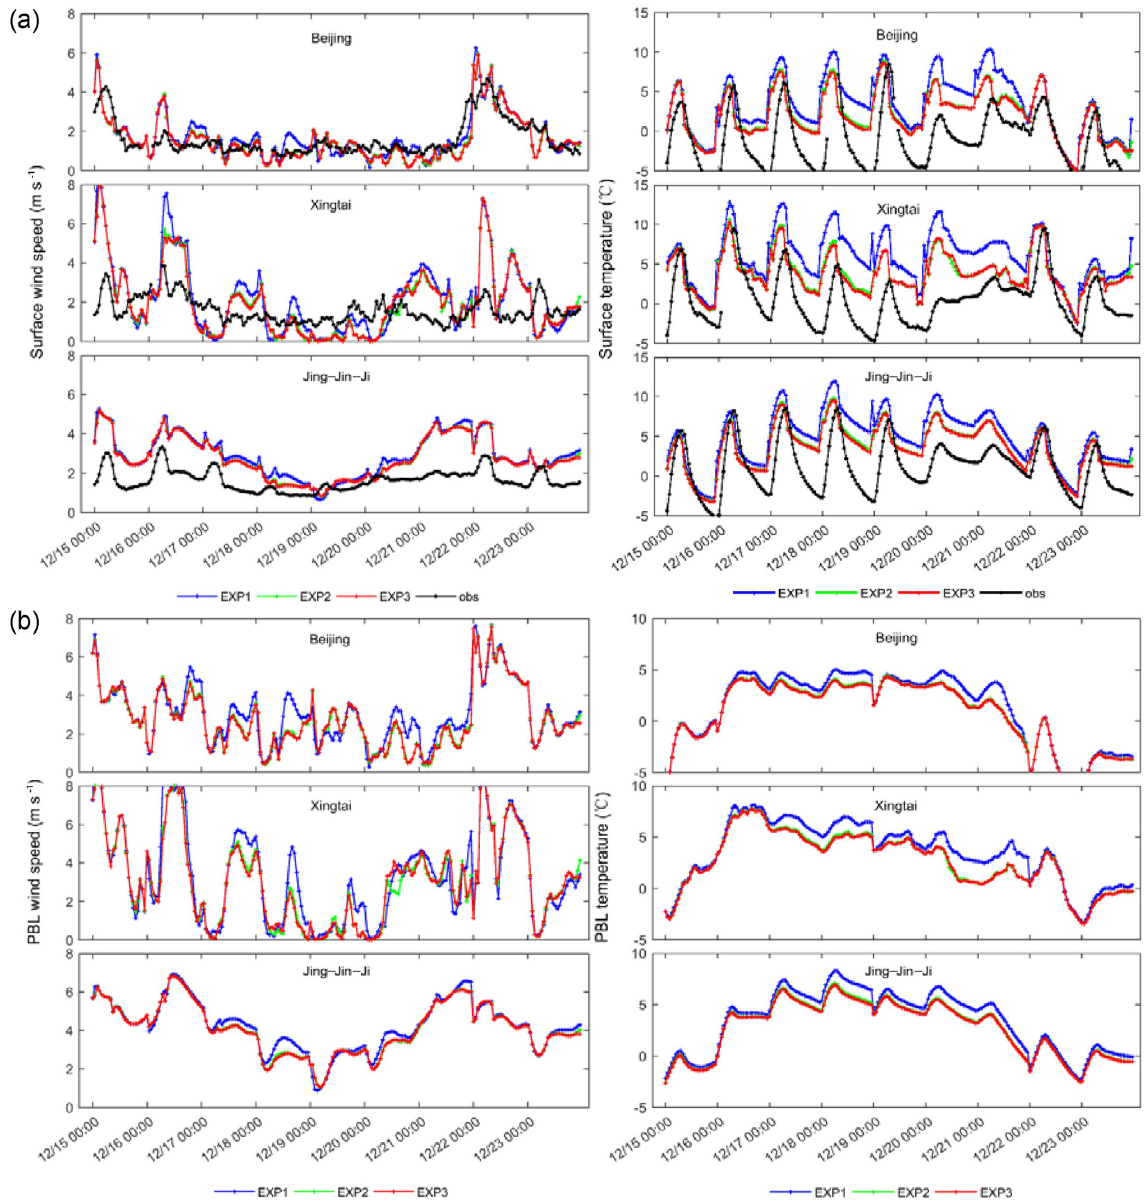
Figure 3. Observed and modelled wind speed and temperature at the surface (a) , and the PBL-mean wind speed and temperature (b) , from the results of EXP1, EXP2, and EXP3 for Beijing, Xingtai, and the average for the Jing–Jin–Ji region as a whole, from 15 to 24 December